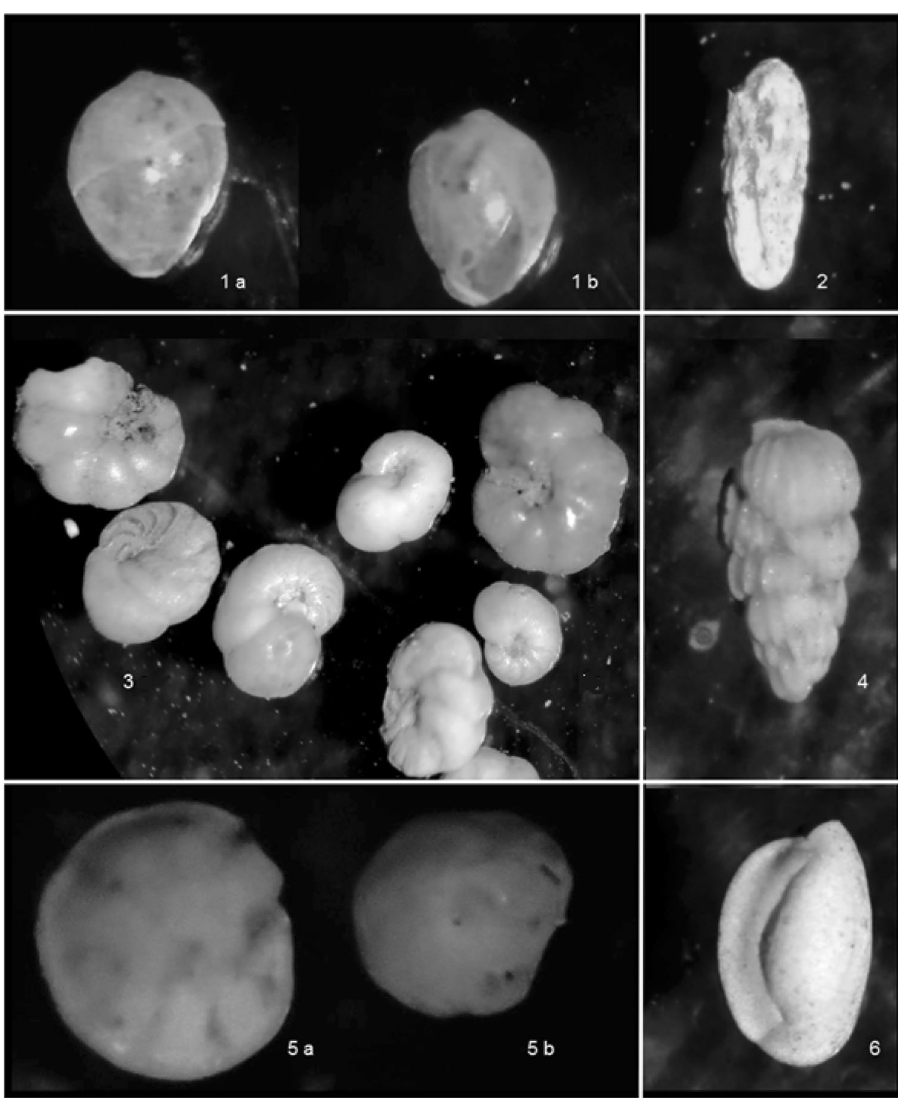
Figure 6. Benthic foraminifera. In (1a) Globobulimina sp., lateral view (10×); (1b) Globobulimina sp., lateral view (10×); (2) Bolivina plicata ., lateral view (5×); (3) Anomalinoides spp., lateral view (5×); (4) Uvigerina peregrina , lateral view (5×); (5a) Oridorsalis tener , lateral view (5×); (5b) Oridorsalis tener , lateral view (5×); (6) Quinqueloculina vulgaris , lateral view